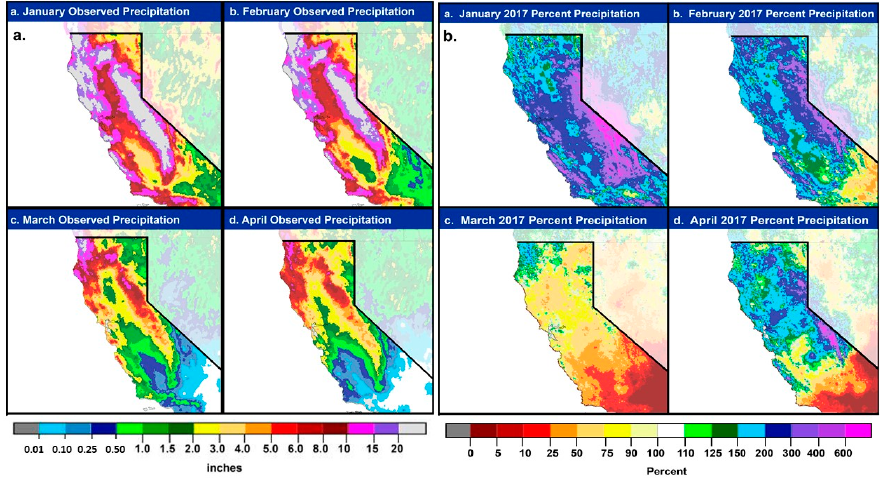
Figure 1. (a) Monthly observed precipitation, and (b) Monthly percent of normal precipitation. Figure 1. ( a ) Monthly observed precipitation, and ( b ) Monthly percent of normal precipitation. (Source: National Weather Service: Advanced Hydrologic Prediction Service Precipitation Analysis